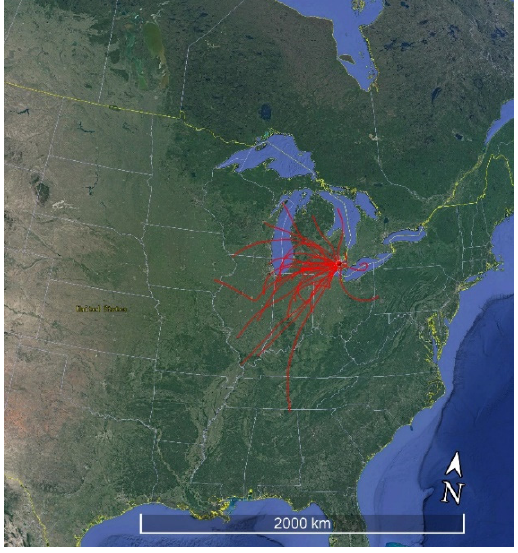
Figure 7. Back trajectories of AQHI = 5 days in warm season. The red dot is Windsor.